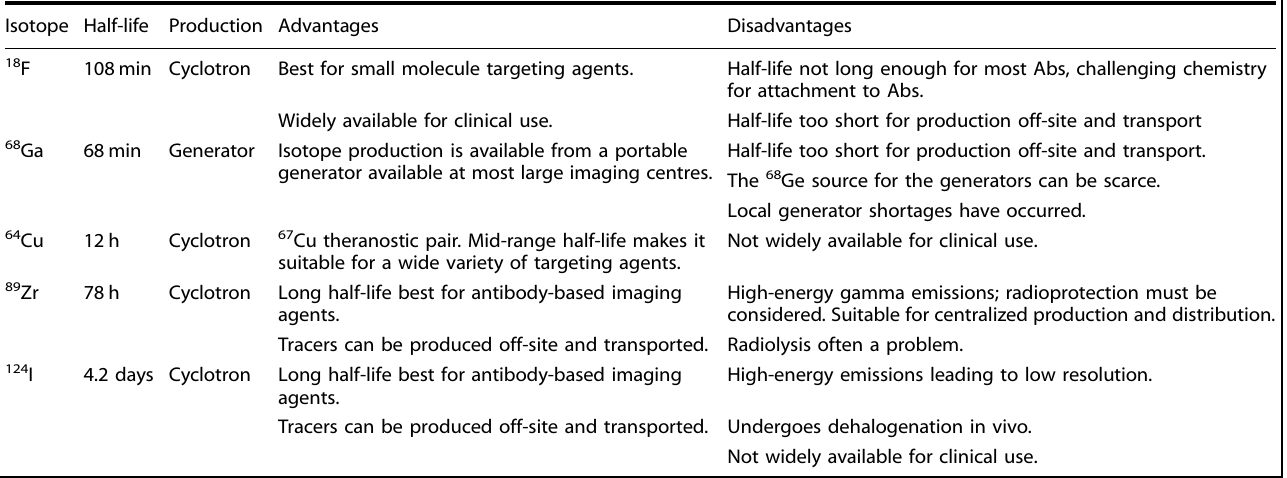
Table 3. A selection of available positron emitting radioisotopes with potential for Immune-PET imaging. Isotope Half-life Production Advantages Disadvantages 18 F 108 min Cyclotron Best for small molecule targeting